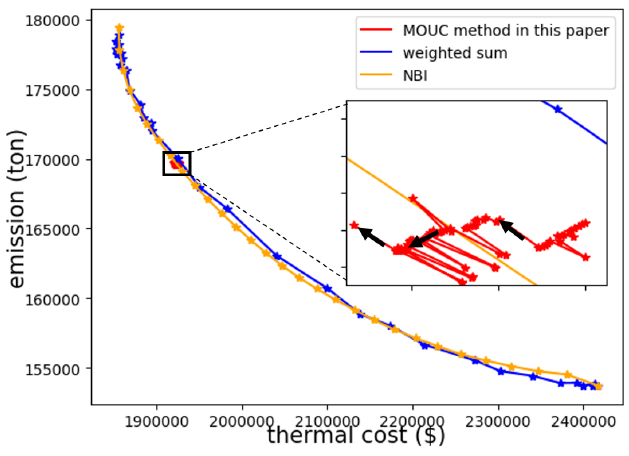
Figure 5. F 1 − F 2